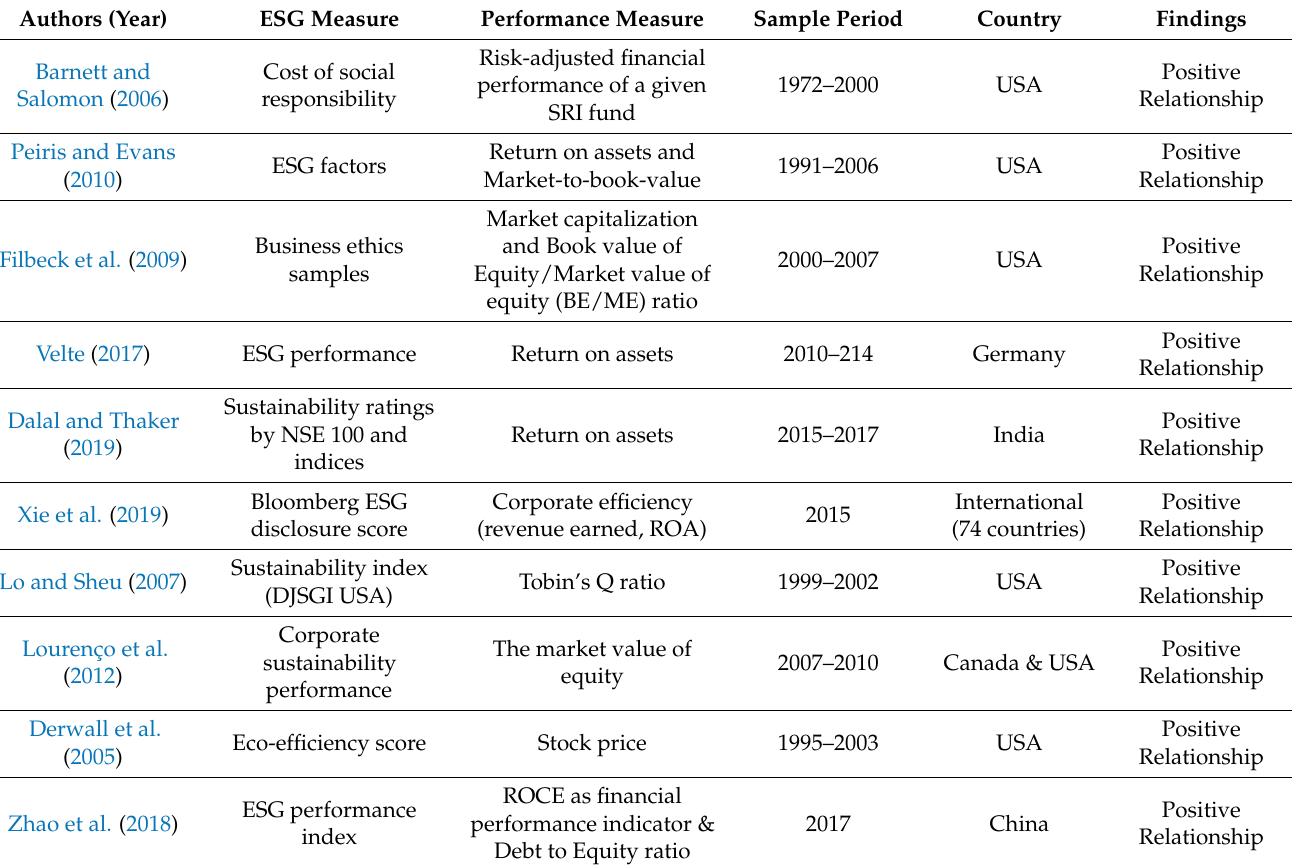
Table 1. Literature on the positive association between ESG and